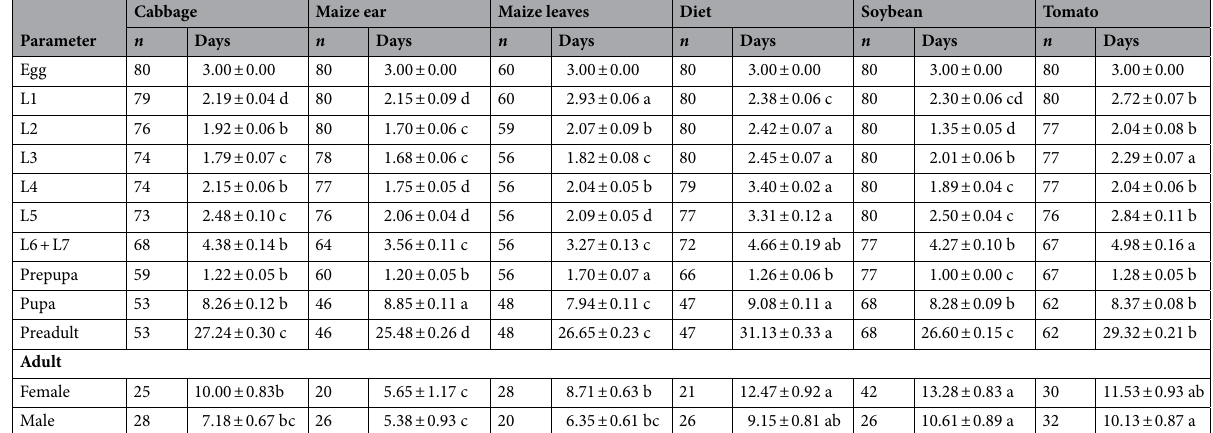
Table 2. Development time and adult longevity (mean ± SE) of the fall armyworm, Spodoptera frugiperda fed on cabbage, maize ear, maize leaves, artificial diet, soybean, and tomato. Standard errors were estimated using 100,000 bootstrap resampling. Data followed by the same lower-case letter within a row were not significantly different based on a paired bootstrap test at 5% significance